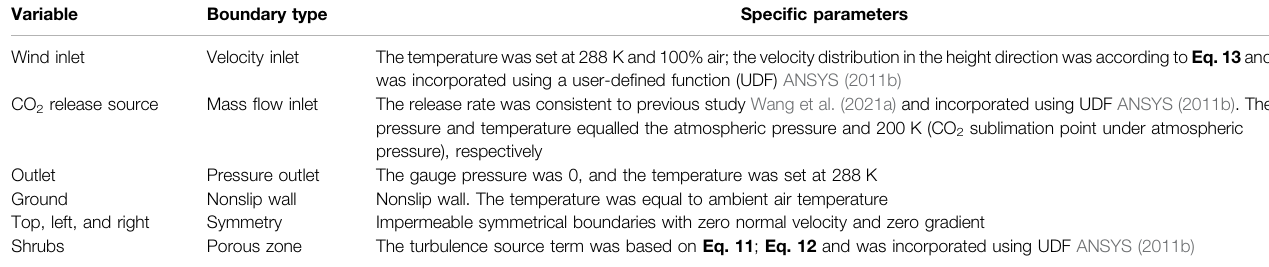
TABLE 3 | Boundary condition.